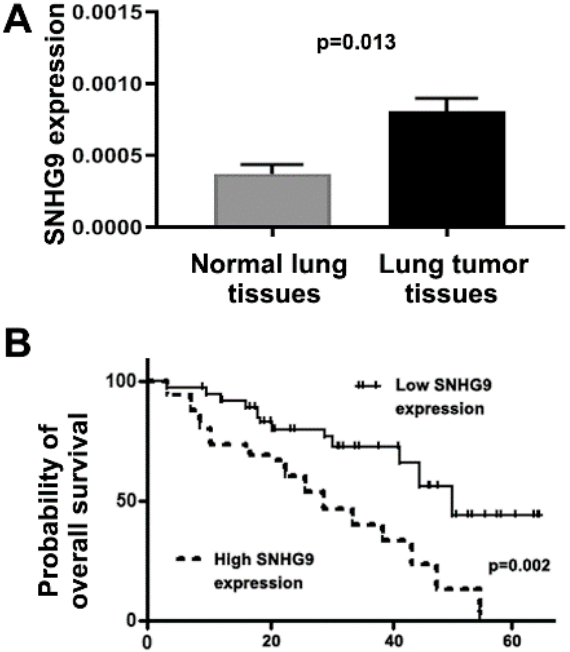
Figure 2. Expression of SNHG9 determined by using RT-PCR in surgically resected lung tumor tissues and the matched noncancerous lung tissues of 78 lung cancer patients. ( A ) SNHG9 has a higher expression level in lung tumor tissues compared with the corresponding noncancerous lung specimens ( p = 0.013). ( B ) The 78 NSCLC patients were classified into two groups according to a median SNHG9 expression value in the lung tumor tissues (0.00034 ± 0.0001). The patients with high expression of SNHG9 in the lung tumor tissues had significantly shorter survival time than those with low expression level of the gene ( p = 0.001).